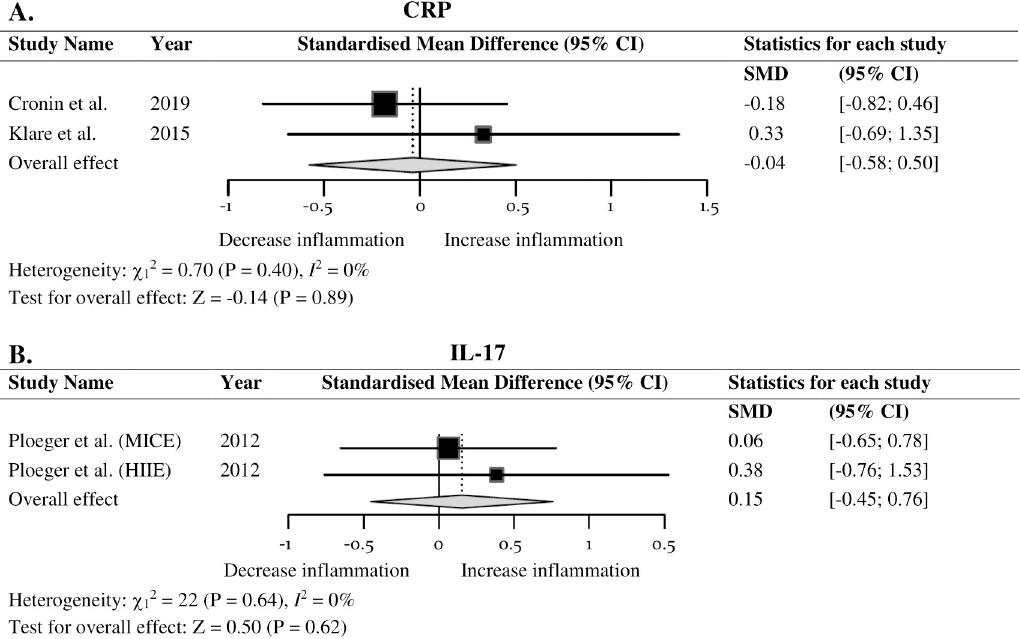
Fig 3. Forest plot of the combined effect of exercise on inflammatory markers in IBD. (A) CRP. (B) IL–17. Size of squares is proportional to weight of the study. Hedges’ g expressed as standardised mean difference ( SMD ) and 95% confidence interval ( CI